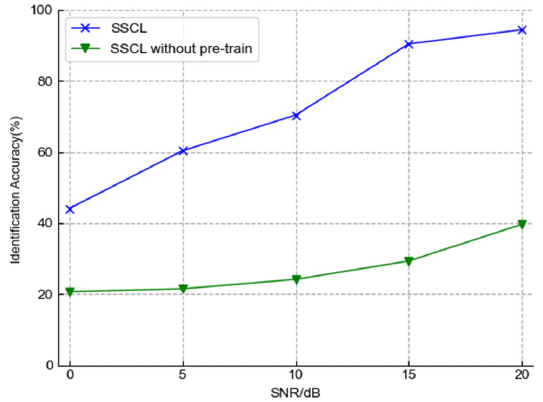
Figure 6. Identification accuracy with or without pre ‐ training.